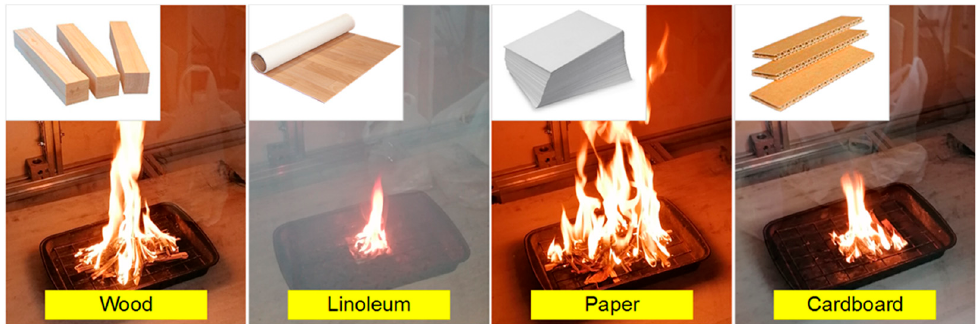
Figure 2. Frames of combustion of model fires involving different materials.